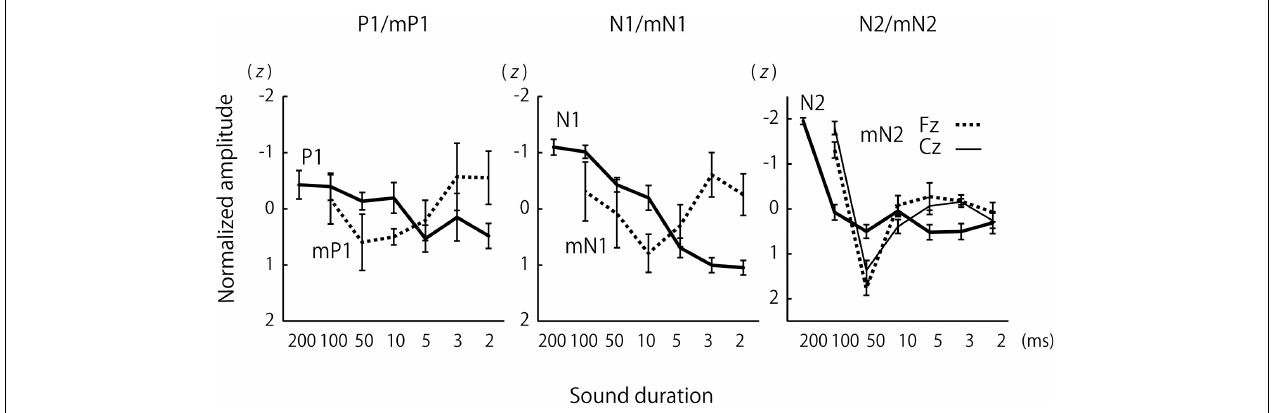
FIGURE 3 | Group comparisons of the effects of sound duration on the amplitudes of P1/mP1, N1/mN1, and N2/mN2. The lines represent group-averages that were calculated after the CAEP amplitudes were normalized to z -scores across the sound duration conditions for each subject. The error bars represent standard